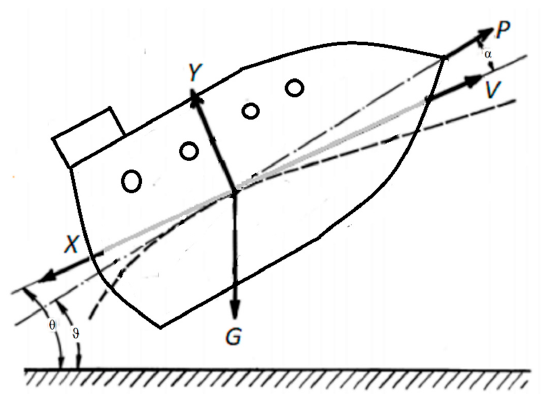
Figure 9. Parameters of the drone’s longitudinal motion.